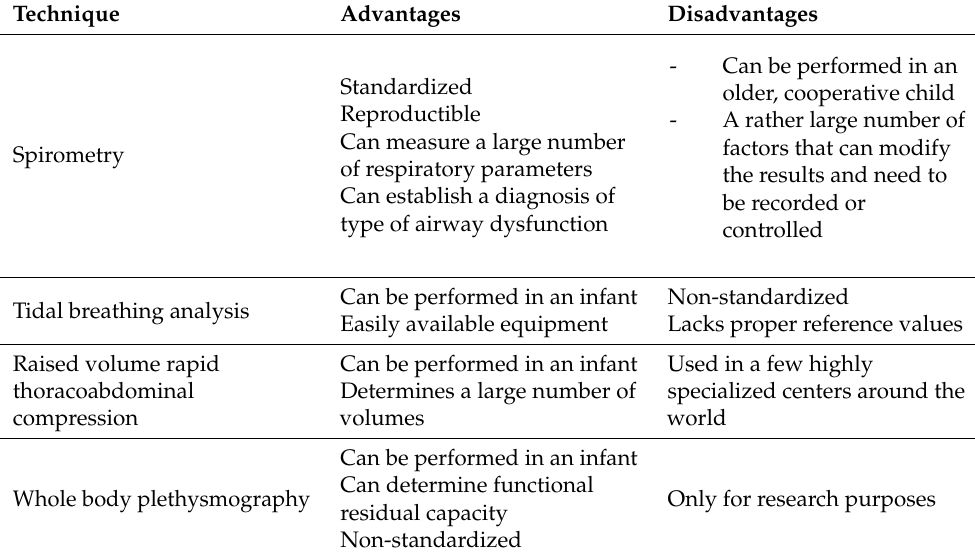
Table 3. Methods of evaluating pulmonary function in children